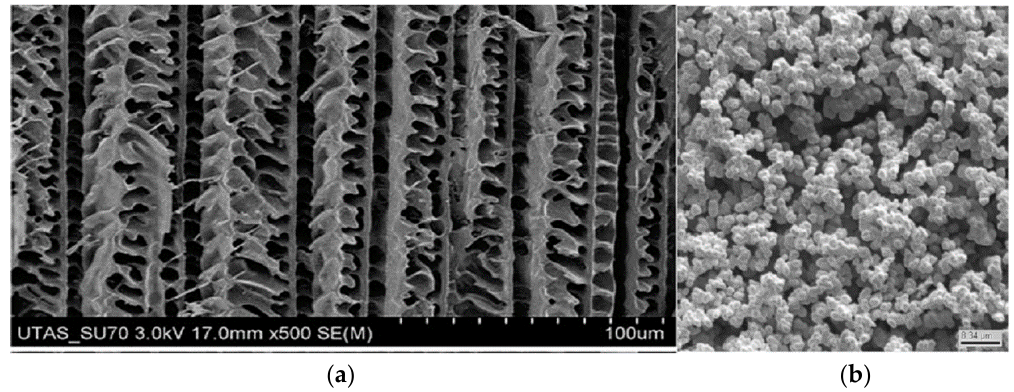
Figure 2. SEM images of ( a ) poly(ethyleneglycol) diacrylate (PEGDA) monolith formed via directional freezing, reproduced from [52] with permission of The Royal Society of Chemistry; and ( b ) a glycidyl methacrylate co- Ethylene DiMethacrylate (EDMA) monolith, reproduced (adapted) with permission from [9], Copyright 2007 WILEY-VCH Verlag GmbH & Co. KGaA, Weinheim, Germany.